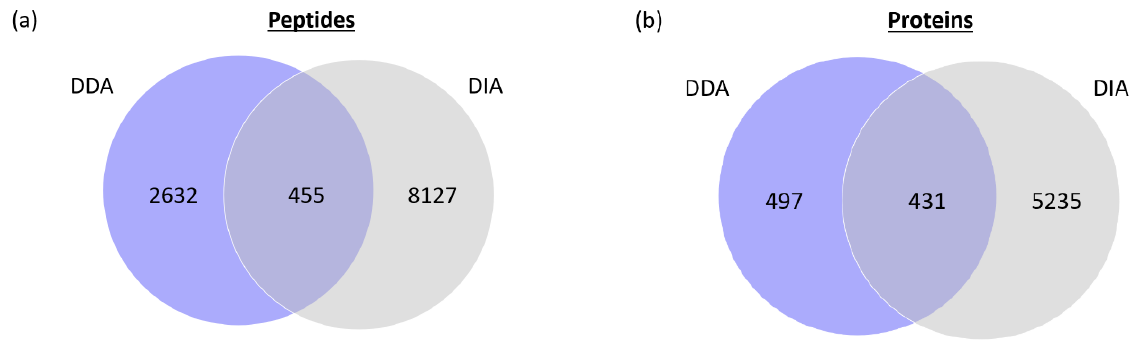
Figure 5. ( a ) Venn diagram representing the number of peptides identified in DDA and DIA; ( b ) Venn diagram representing the number of proteins identified in DDA and DIA. Displayed numbers are pool of peptides and proteins obtained in three runs. Analytical column: µPAC 50 cm; column temperature: 25 °C; Sample: 500 ng Pierce™ HeLa Protein Digest Standard.